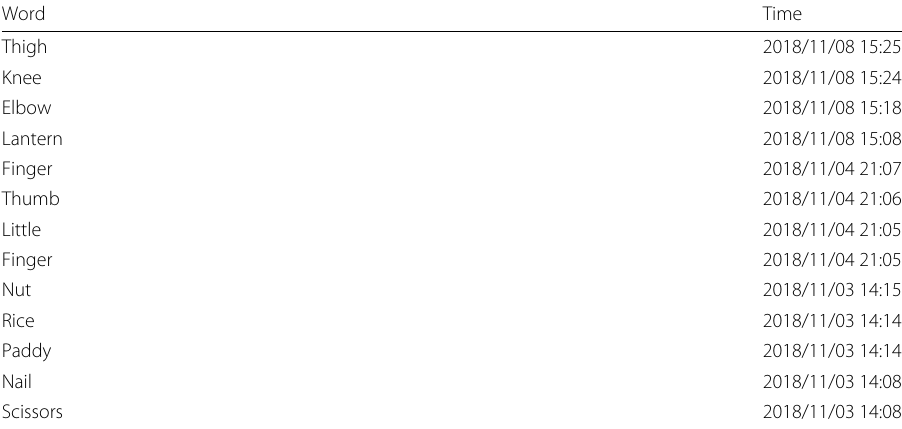
Table 2 Learner’s vocabulary and dates of